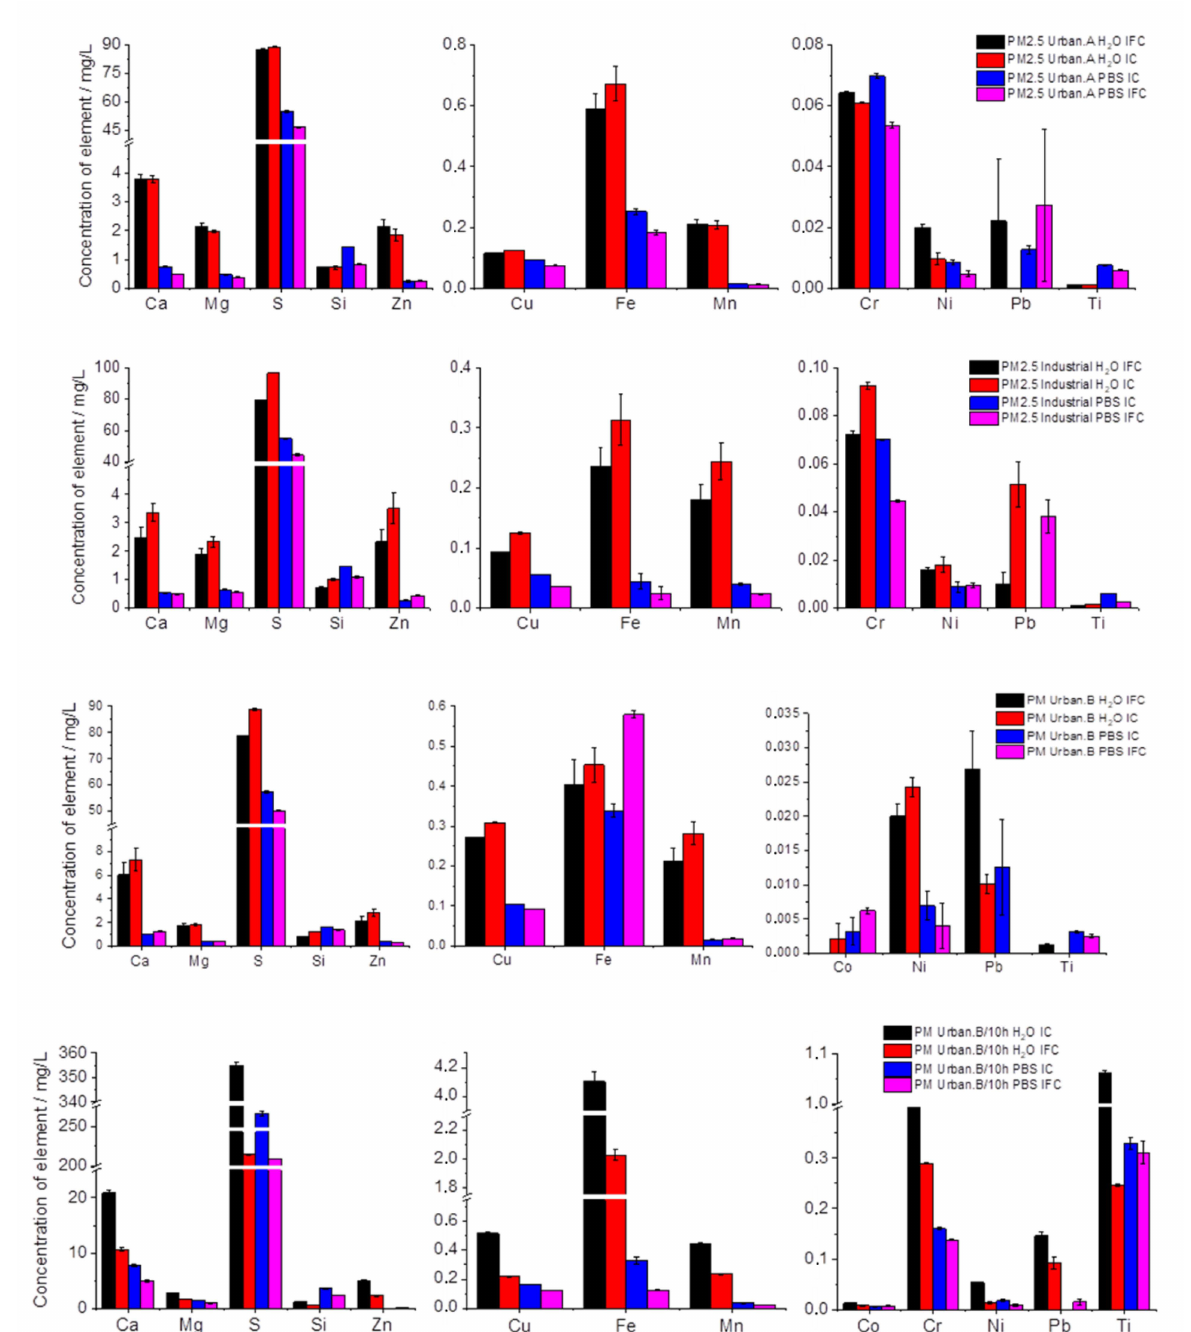
Figure 6. Selected elements for water and PBS soluble compounds from Krak ó w particulate matter (I—incubation, F—filtration,